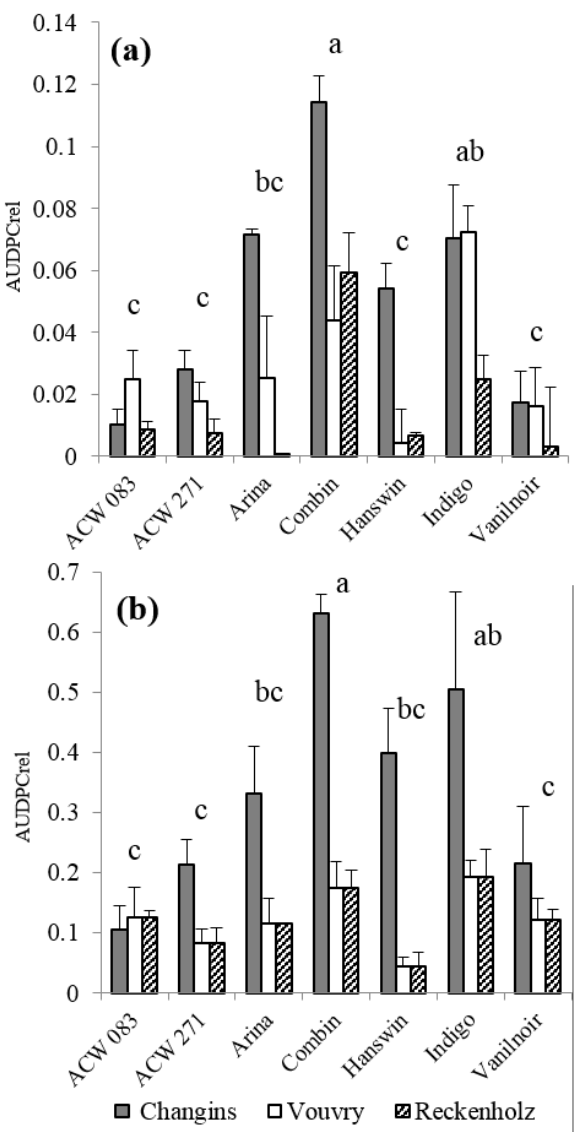
Figure 1. Means of rel. AUDPC for (a) FHB severity and (b) FHB incidence on 7 wheat genotypes in Changins, Vouvry and Reckenholz. Bars accompanied by with the same letter are not statistically different ( P